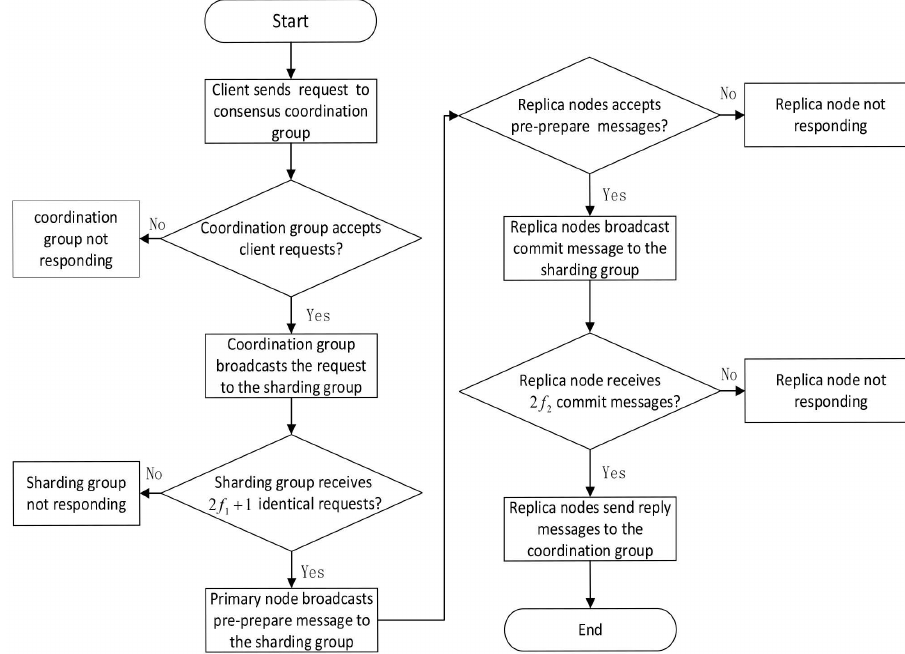
Figure 3. Transaction verification flow chart.